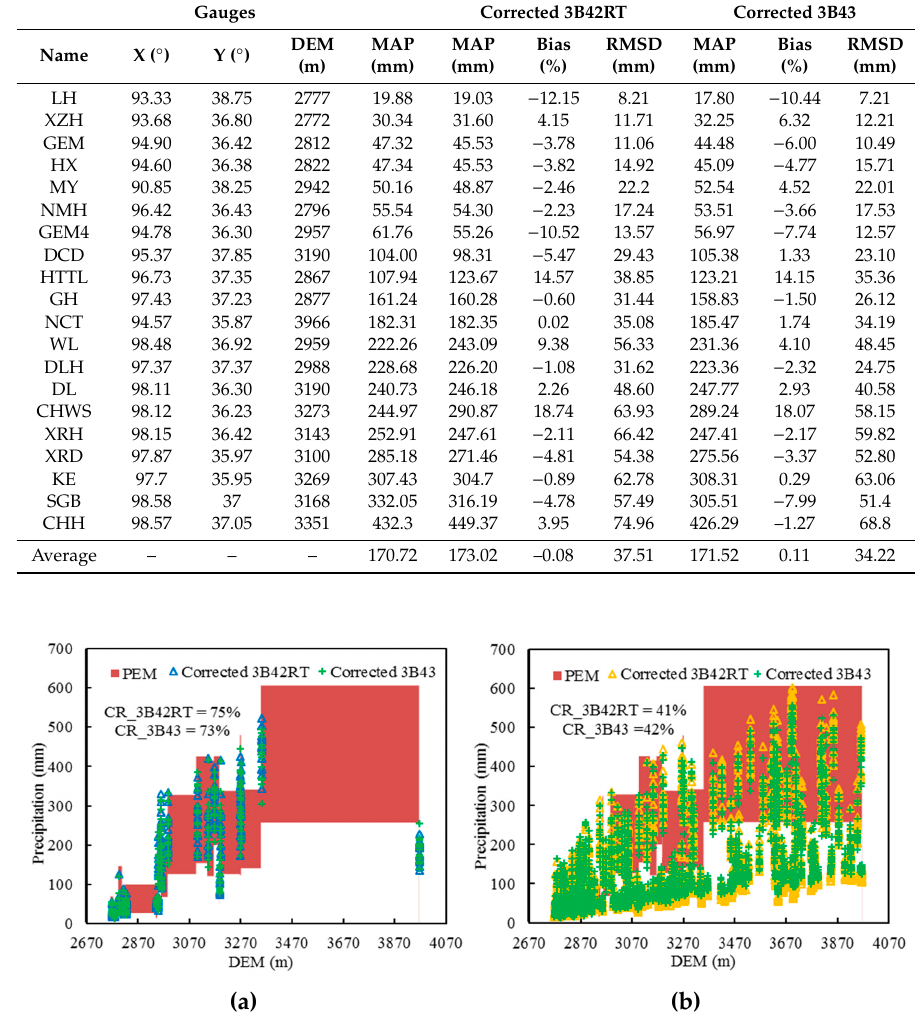
Figure 6. The consistency rate (CR) elevation for corrected TRMM from 2001 to 2016 in the Qaidam Basin. ( a ) Gauged grids. ( b ) Ungauged grids. Basin. ( a ) Gauged grids. ( b ) Ungauged